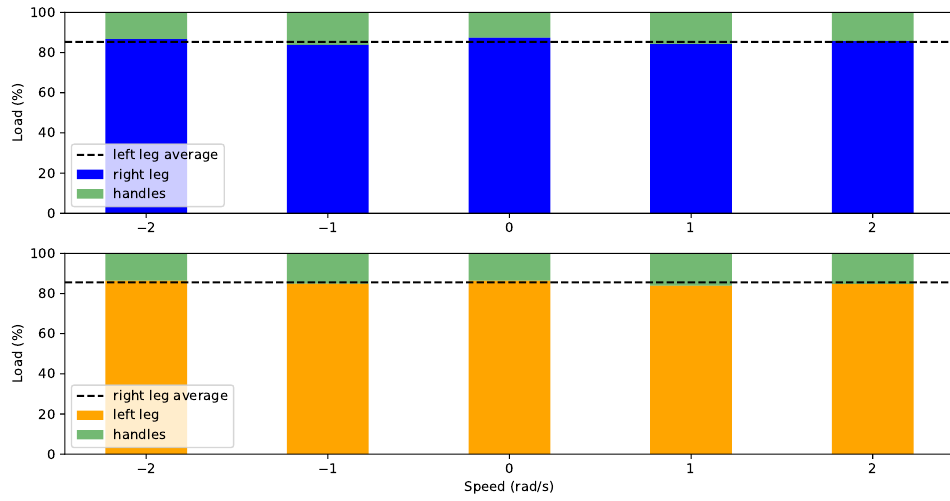
Figure 11. Weight bearing on support leg for user 1 by steering angle.